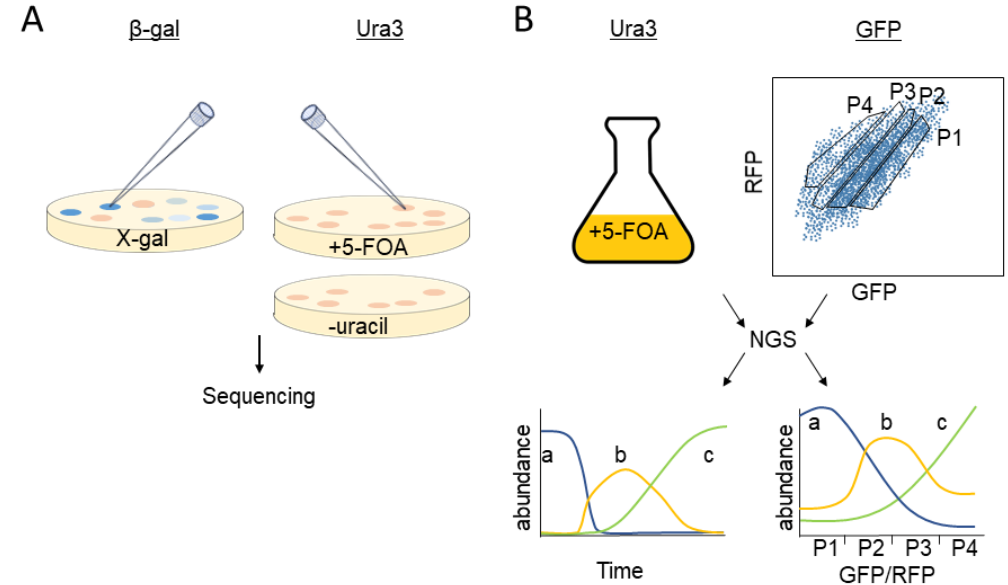
Figure 2. Methods for degron discovery. ( A ) Colony isolation on solid media. Left, yeast mutants, defective in β -gal-degron degradation are detected by dark blue appearance of yeast colonies. Right, degrons in Ura3-expressing cells are detected by the ability of yeast cells to grow on plates containing the orotic acid derivative 5-FOA or the inability to grow in the absence of uracil. ( B ) Isolation of degron from cells grown in liquid media. Left, degrons in Ura3-expressing yeast cells are isolated from cells after prolonged growth period in the presence of 5-FOA. The degron potency correlates with its abundance in the yeast population so that the frequency of stronger degron increases with time. Right, cells expressing fluorescence markers are divided by fluorescence-activated cell sorting (FACS) into separated bins, based on their cellular GFP / RFP ratio. Strong degrons are present in bins with low GFP / RFP ratio (P4). a—no degron; b—intermediate degron; c—strong degron. 5-FOA: 5-fluoroorotic acid; NGS: next generation sequencing; RFP: red fluorescent protein.